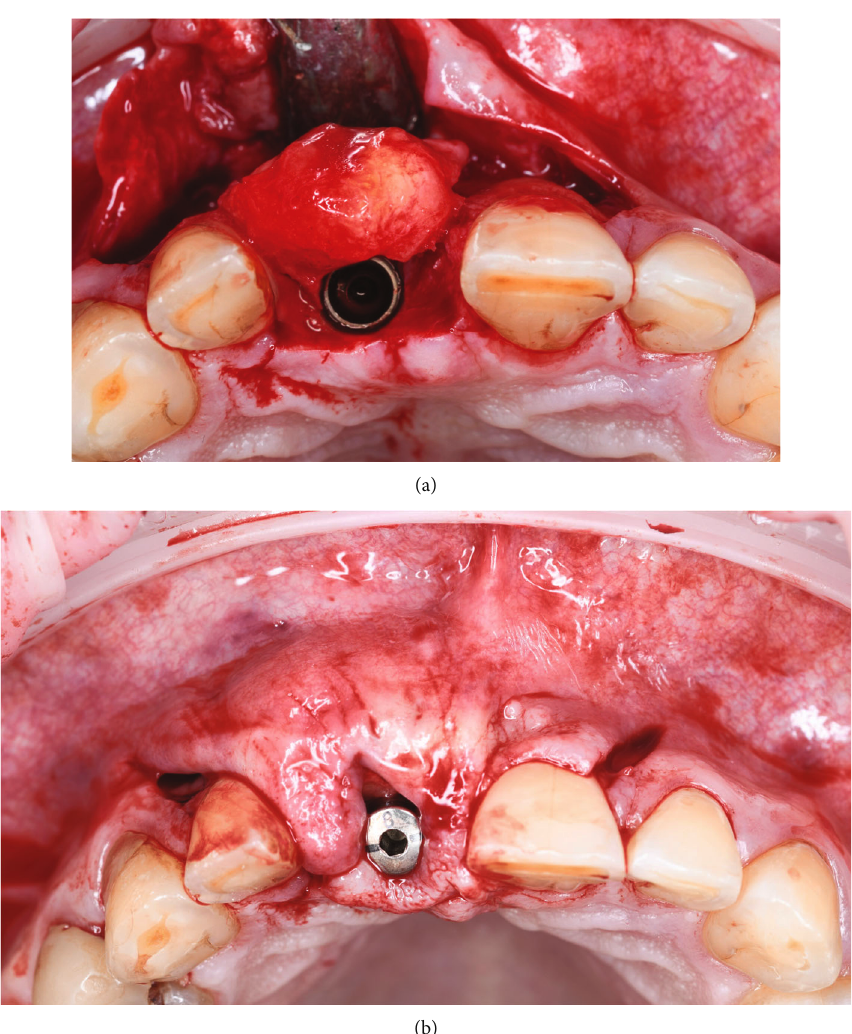
Figure 10: An AstraTech OsseoSpeed ™ TX implant with a standard healing abutment.